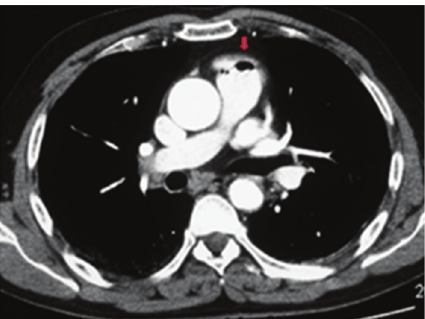
Figure 8: An axial CT scan shows air embolism with air in the pulmonary artery following withdrawal of a central venous line (arrow).